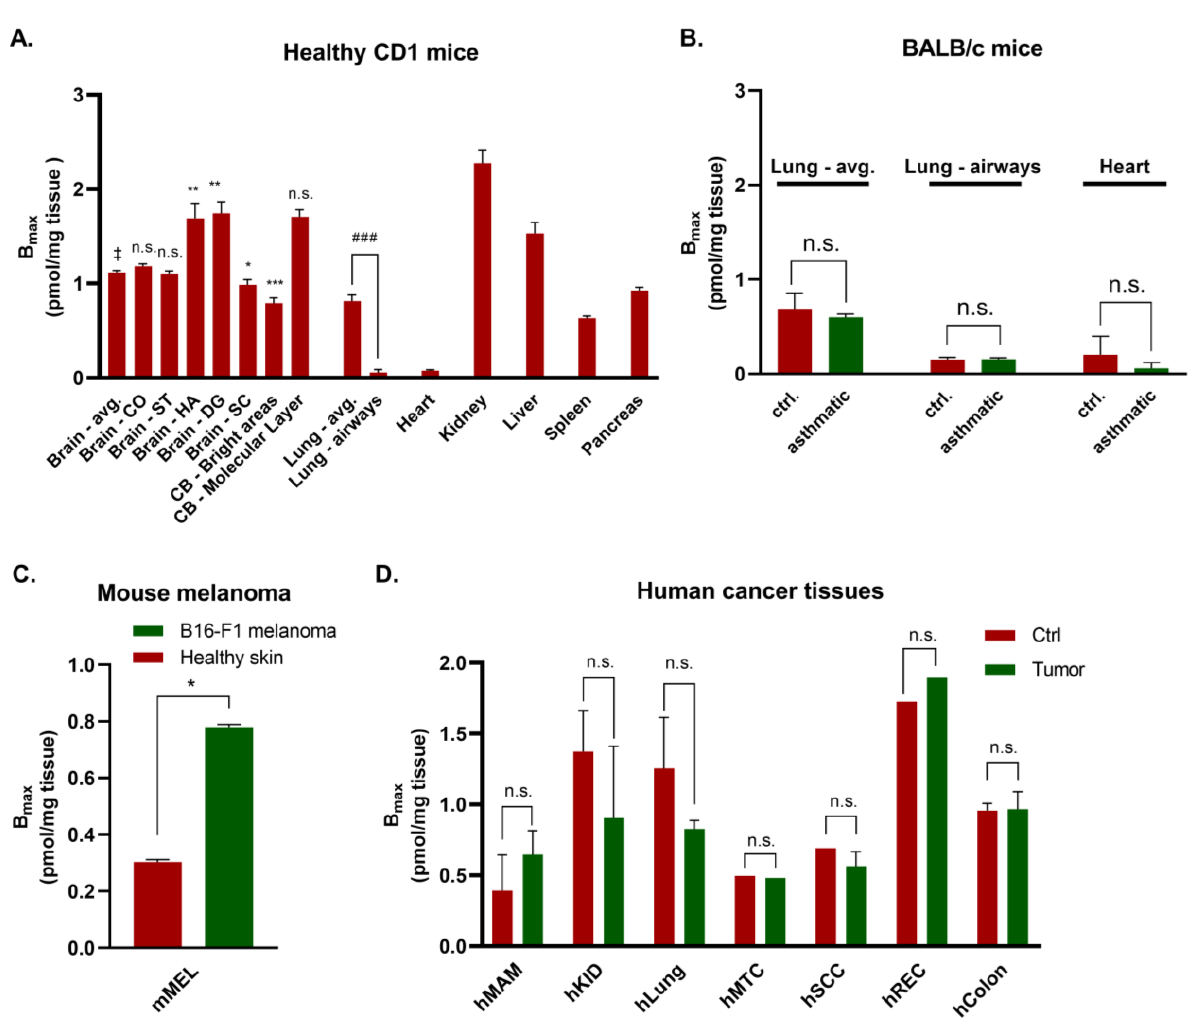
(Figure 2E, 0.63 pmol G α q /mg tissue). In sections of the pancreas, intermediate levels of G α q protein expression were observed (0.93 pmol G α q /mg tissue). Areas displaying no specific binding included excretory ducts and septa, which subdivide the pancreas into irregular lobes (see Figure 2F).